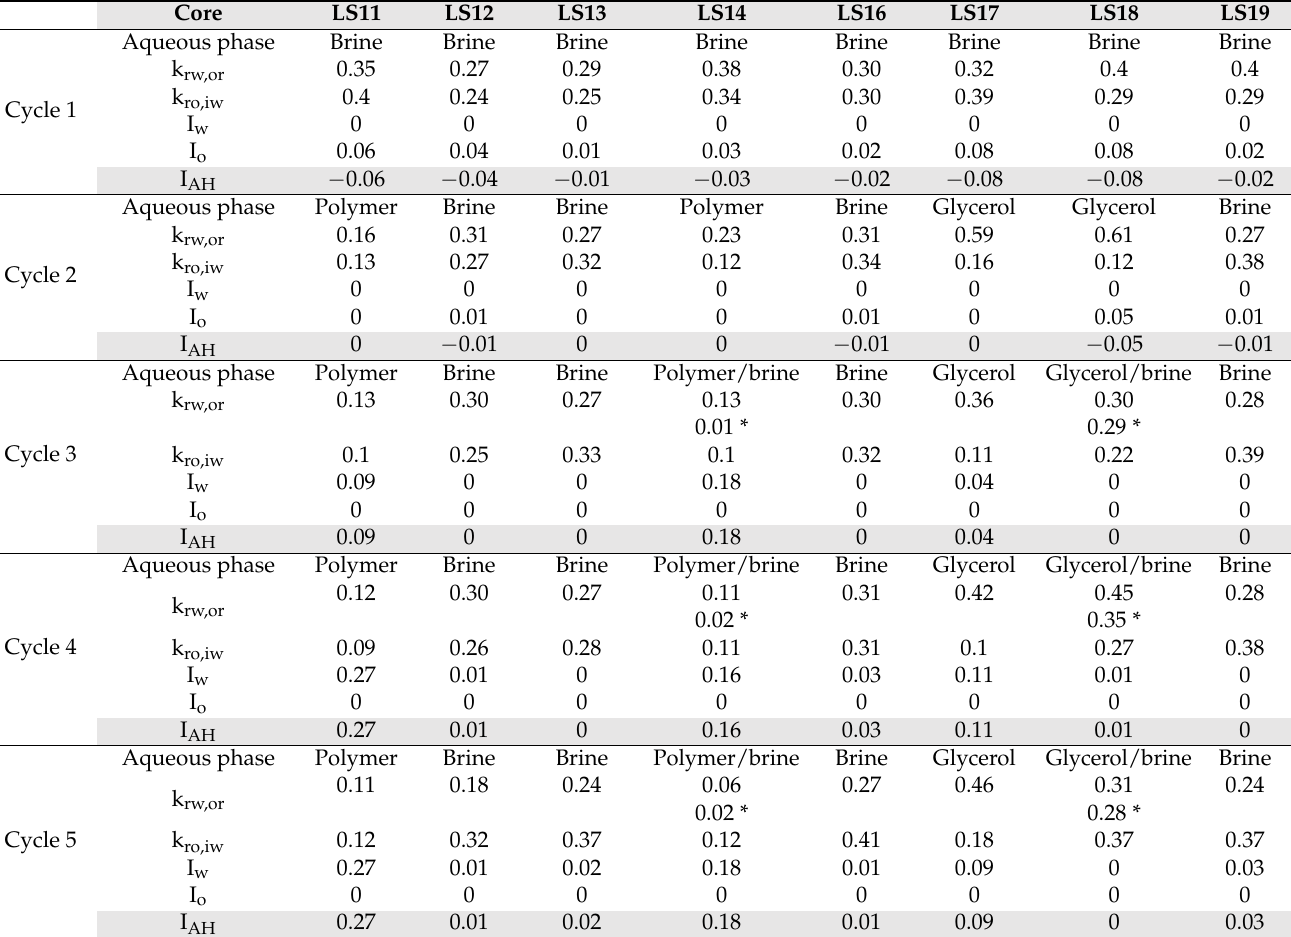
Table 4. Core scale parameters measured during five consecutive Amott–Harvey cycles. Cores LS12, 13, 16, and 19 were previously detailed in [17]. * indicates the end point measurements after polymer/glycerol was displaced by